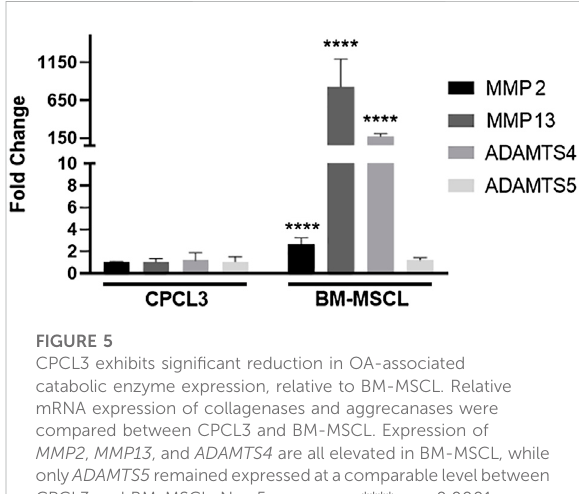
FIGURE 5 CPCL3 exhibits signi fi cant reduction in OA-associated catabolic enzyme expression, relative to BM-MSCL. Relative mRNA expression of collagenases and aggrecanases were compared between CPCL3 and BM-MSCL. Expression of MMP2 , MMP13 , and ADAMTS4 are all elevated in BM-MSCL,